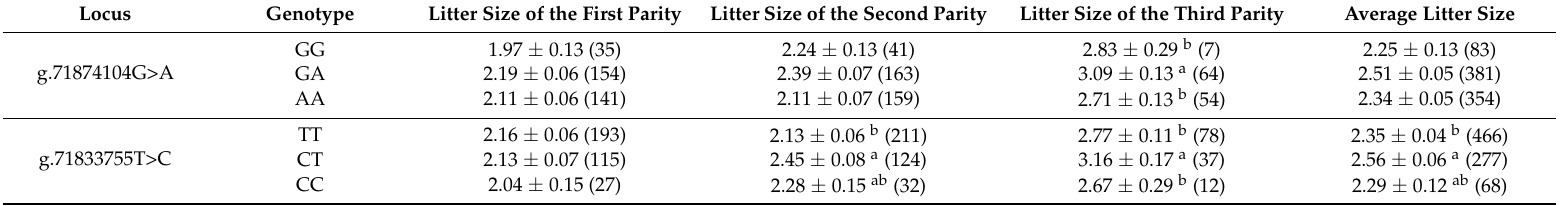
Table 4. Least squares means and standard error of litter size in Small Tail Han Sheep with different g.71874104G>A and g.71833755T>C genotypes.